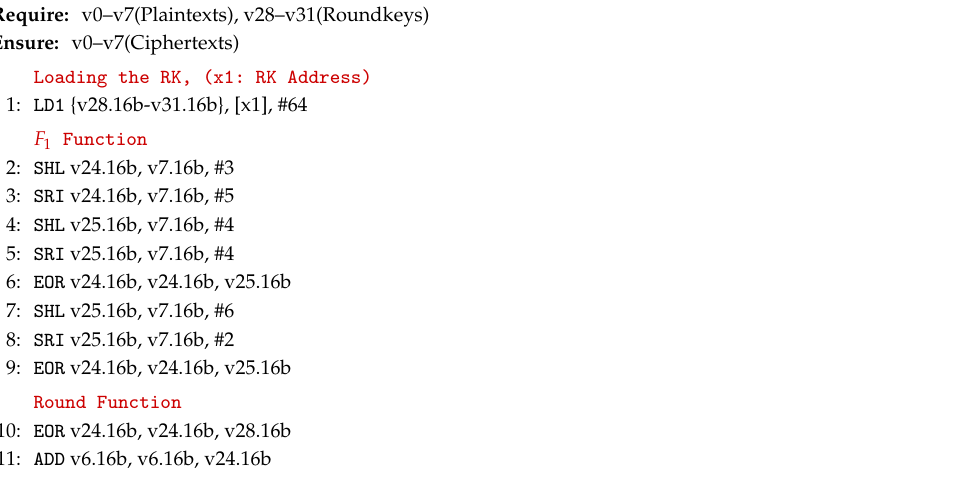
Algorithm 3 Data parallel implementation of HIGHT Round